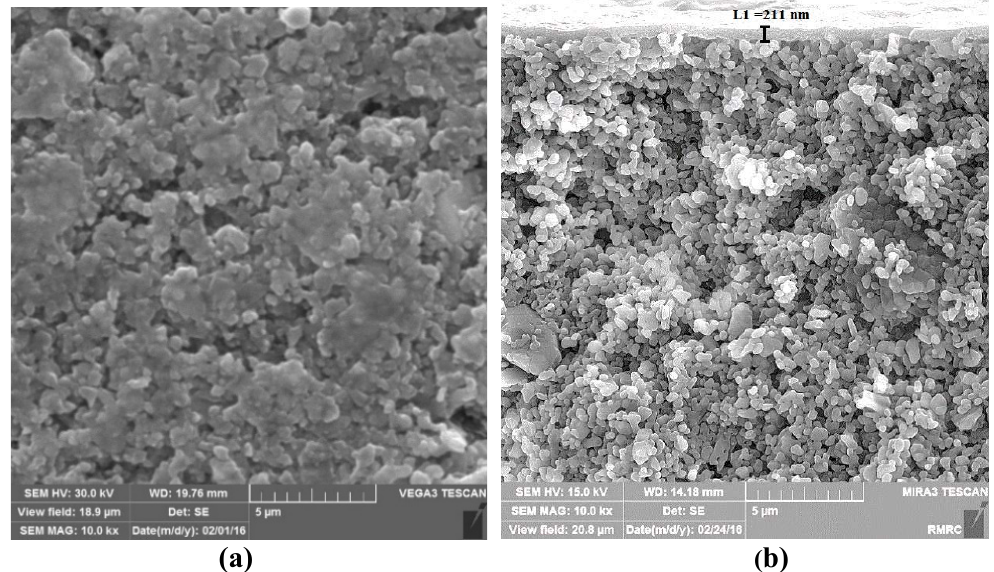
Fig. 4: FE-SEM image of Alumina/PDMS hybrid nanofiltration membrane (M2). (a) Top view, (b) Cross-section